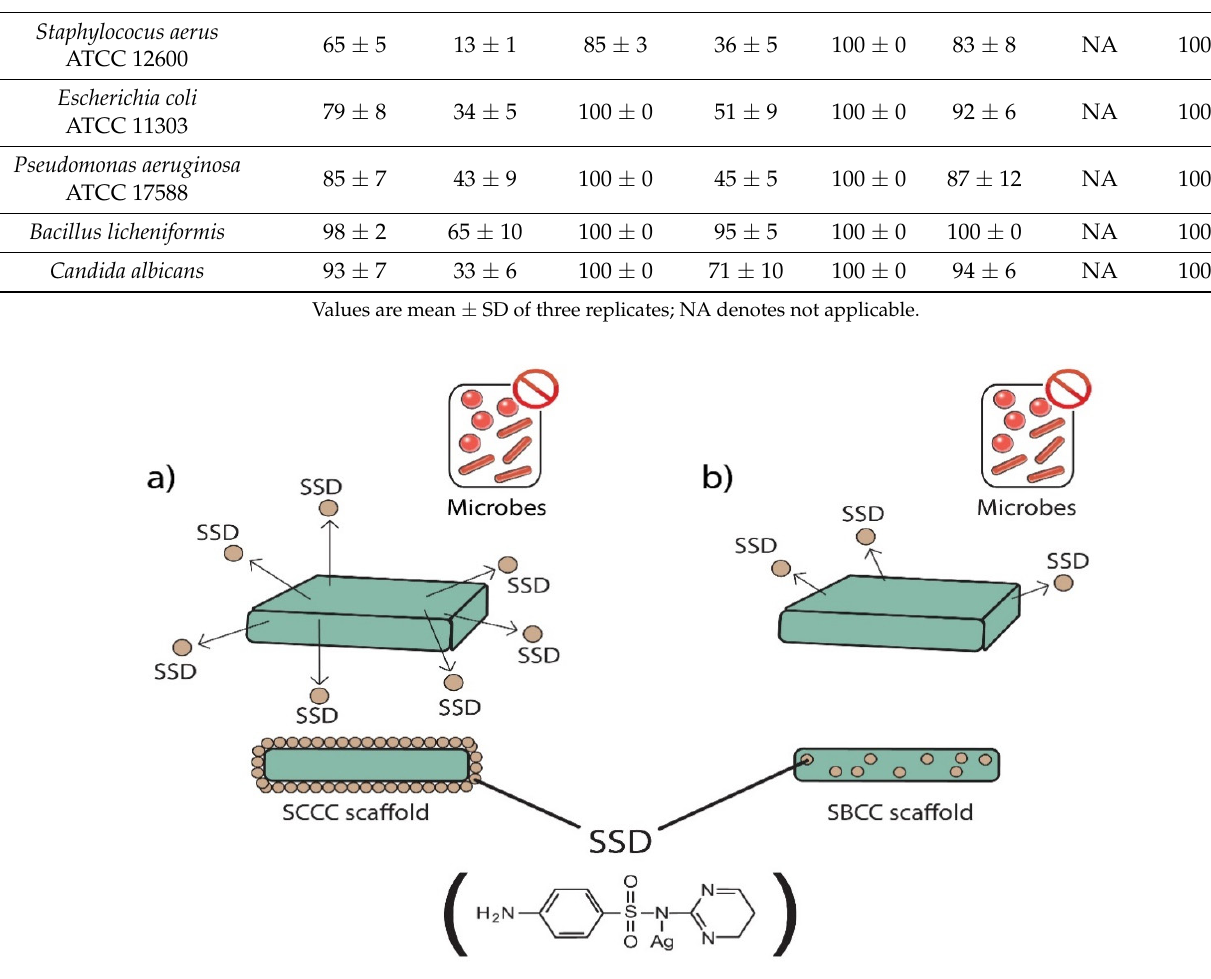
Table 4. Antimicrobial test of SCCC and SBCC scaffolds against various microorganisms . Time (h)